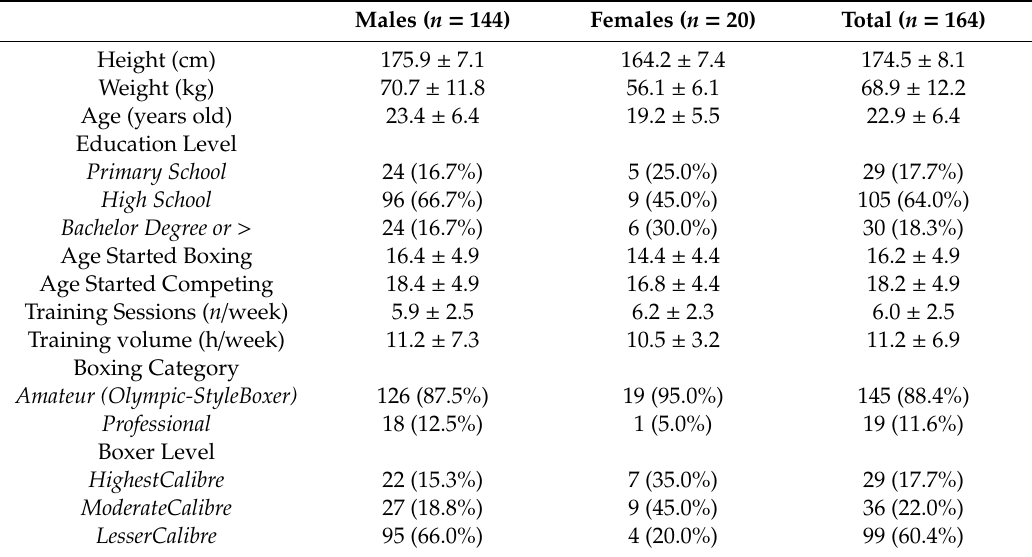
Table 1. Participants characteristics. Data are reported as means ± standard deviations. For asymmetric values, median (min–max) have been used. Where applicable, absolute frequencies (percentage) are